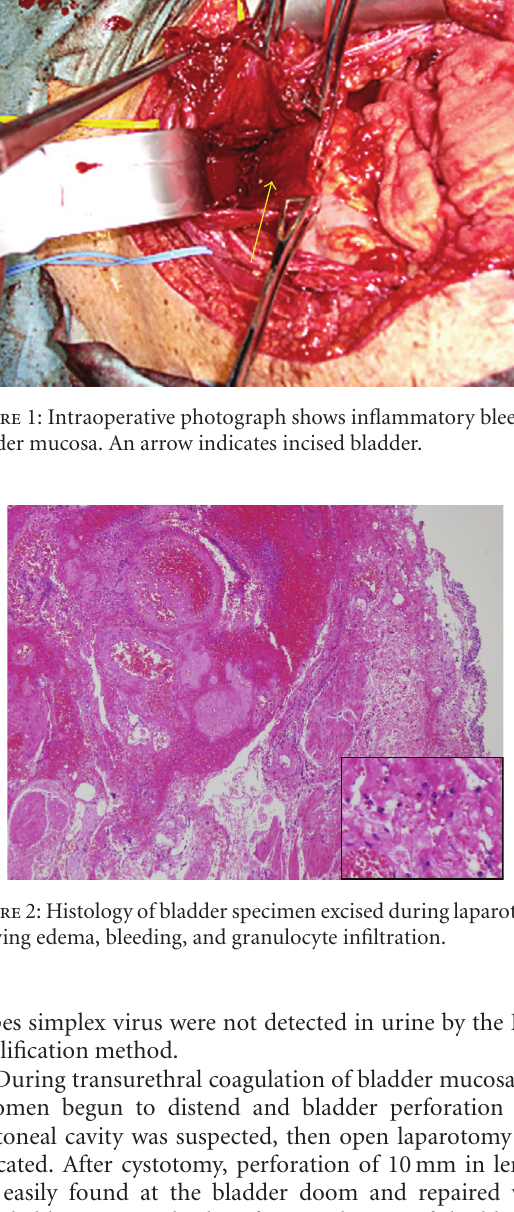
herpes simplex virus were not detected in urine by the PCR amplification